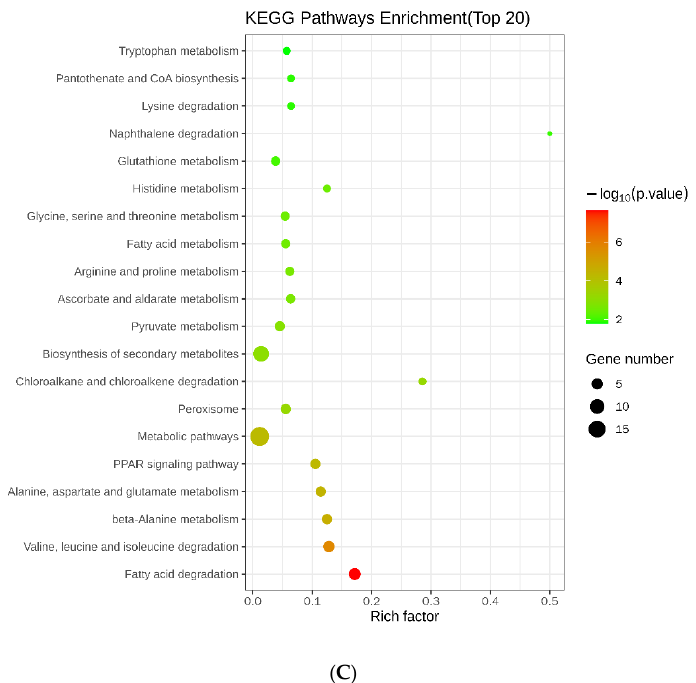
Figure 3. Expression profilling and enrichment of U. hordei responsive transcriptome. ( A ) volcano plot of different expression genes. Significantly up − regulated genes are shown by redpoint and down − regulated by green point; ( B ) GO enrichment of DEGs. Hypergeometric tests were performed based on the GO classification of DEGs. Ordinate is gene number, and p value of various GO terms are shown by color from orange to red. ( C ) KEGG enrichment of DEGs. Hypergeometric tests were performed based on the KEGG classification of DEGs. Abscissa is rich factor defined as ratio of DEG number and the number of genes has been annotated in this pathway; point size represents DEG number; p value, shown by color form green to red.